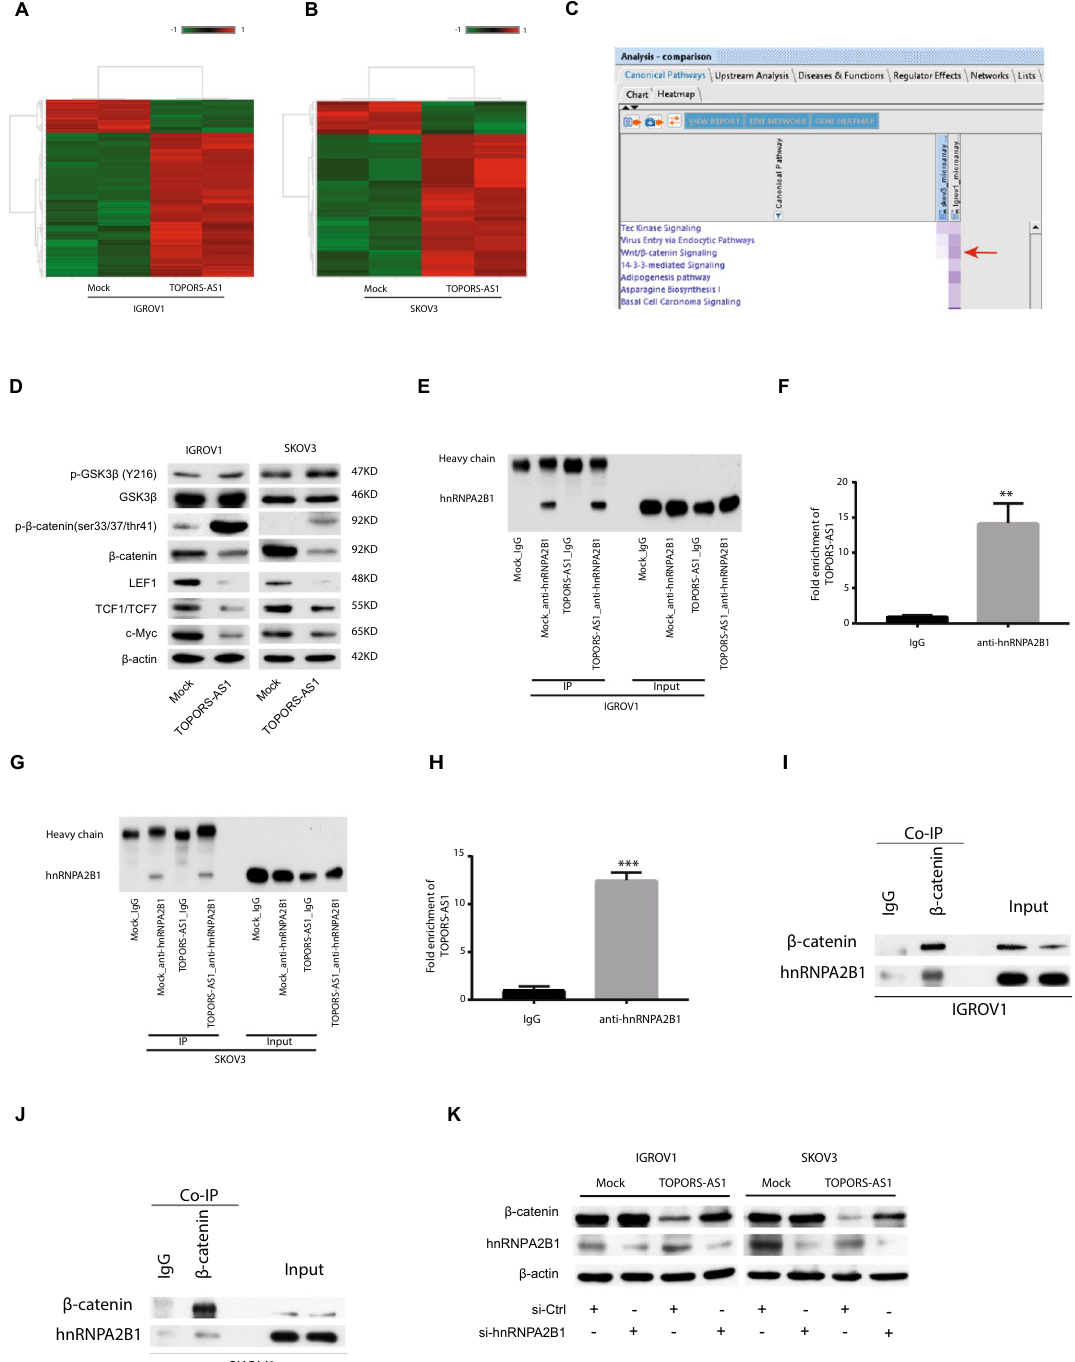
Figure 3. Transcriptomic analysis of ovarian cancer cells associated with TOPORS-AS1 expression and discovery of β-catenin involvement. ( A , B ) Heatmap of differentially expressed genes due to TOPORS-AS1 overexpression in IGROV1 and SKOV3. ( C ) IPA results of common pathways associated with TOPORS-AS1 overexpression in both IGROV1 and SKOV3. ( D ) Western blot results showing reduced β-catenin, LEF1, TCF1/TCF7 and c-Myc, increased phosphorylation of β-catenin, and no changes in GSK3β (either total or phosphorylated) in both IGROV1 and SKOV3 due to TOPORS-AS1 overexpression. ( E , G ) Western blot results showing the pulldown of hnRNPA2B1 in mock and TOPORS-AS1 transfected IGROV1 and SKOV3. ( F , H ) RIP results showing marked enrichment of TOPORS-AS1 in cell extracts processed with anti-hnRNPA2B1 antibody pulldown, but not in IgG pulldown, from IGROV1 and SKOV3. ( I , J ) Co-immunoprecipitation (IP) results suggesting β-catenin binding to hnRNPA2B1 in IGROV1 and SKOV3. ( K ) Western blot results showing that β-catenin suppression by TOPORS-AS1 could be reversed by knockdown hnRNPA2B1 through si-hnRNPA2B1 in IGROV1 and SKOV3. ***P < 0.0001; **P <